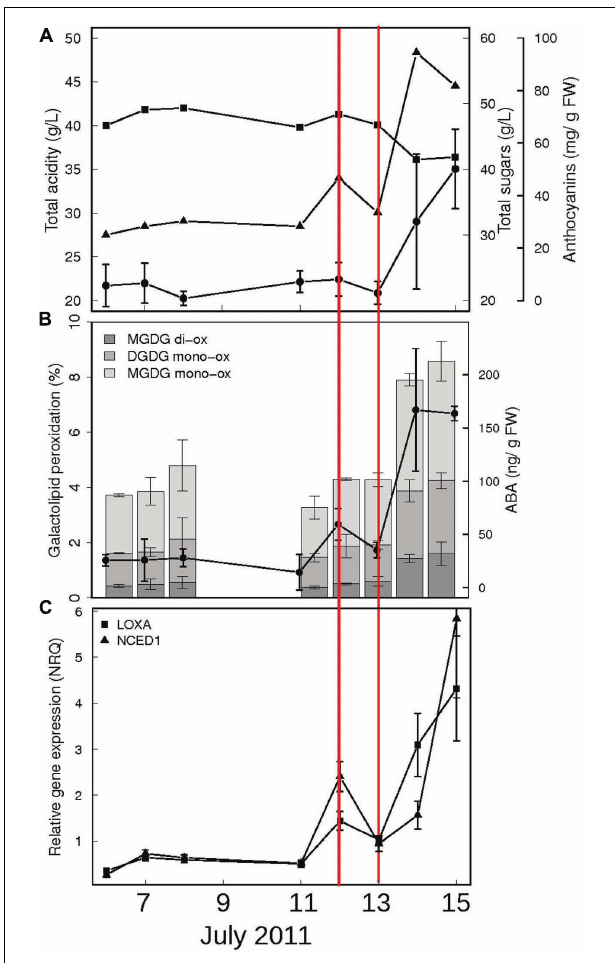
FIGURE 1 | Biochemical and molecular profiling of Pinot Noir berries at the onset of ripening (season 2011). (A) Mean values of total acids (squares, expressed as grams of tartaric acid per liter) and sugars (triangles, expressed as total soluble solids in ◦ Brix) of the must obtained from two clusters, at each time point. Berry skins anthocyanin content (circles) is expressed as grams of mg cyanidin-3-glucoside per gram of berry fresh weight. (B) Total galactolipid peroxidation (stacked bars) and ABA content (circles) in berry skins. The mono-oxidized and di-oxidized forms of MGDG 36:6 and DGDG 36:6 are shown as percentage of total MGDG and DGDG, respectively. Data are means of two biological replicates ± SD. (C) PnLOXA (squares) and NCED1 (triangles) gene expression in berry skins. Normalized relative quantities ± SE were calculated using three reference genes; n = 2. The x -axis represents actual sampling date during July 2011. The precise moment preceding ripening start is indicated between red lines (July, 12th).